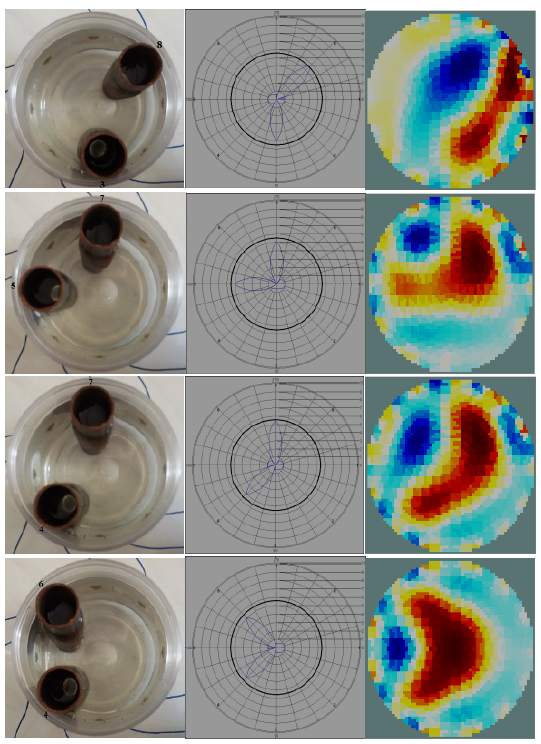
Figure 7: Compiled two object test results for different